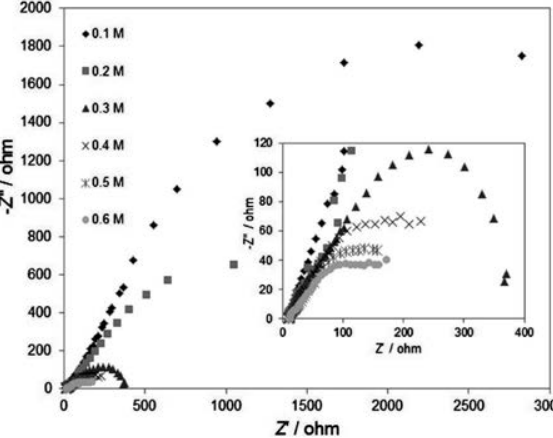
Figure 8. Nyquist diagrams of Ni-Cu electrode in 1 M NaOH solu- tion containing different concentration of ethanol at an anodic po- tential of 500 mV. Inset: high frequency part of the Nyquist diagram.